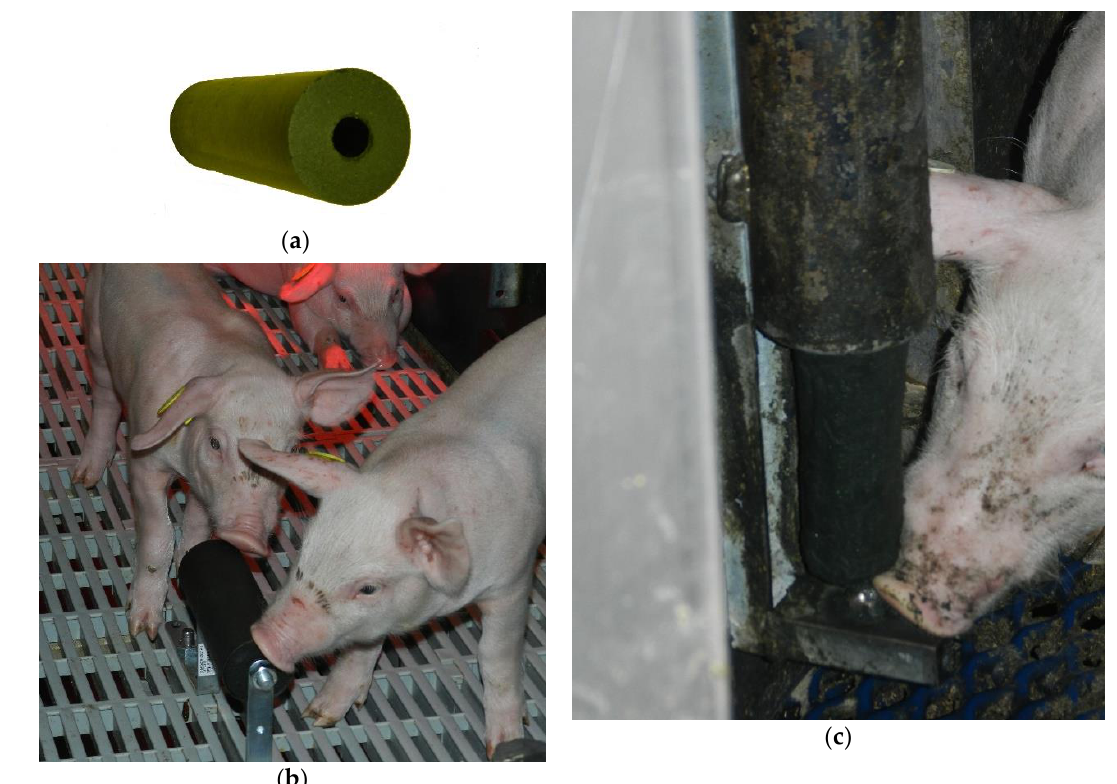
Figure 1. Enrichment materials: ( a ) algae material made of brown algae Saccharina latissimi , post-harvest dried and compressed under heat into a cylinder (15 × 5 cm, 380 g); ( b ) horizontal algae roll dispenser in the farrowing pens; ( c ) vertical algae roll dispenser in the post-weaning and fattening pens.